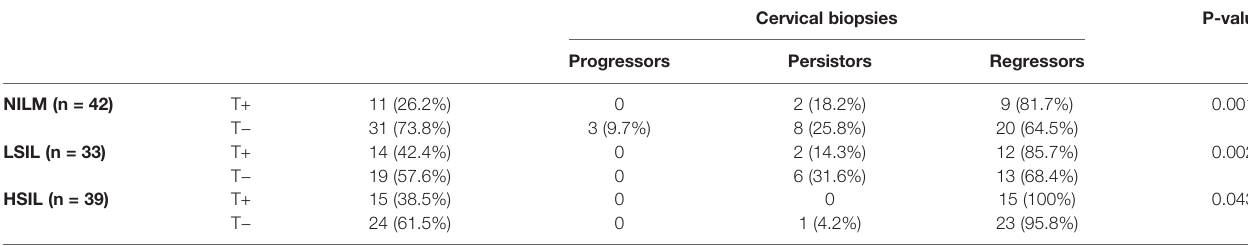
TABLE 4 | Results of cervical biopsy test from women with HPV16 E7-speci fi c T lymphocyte response at study exit.